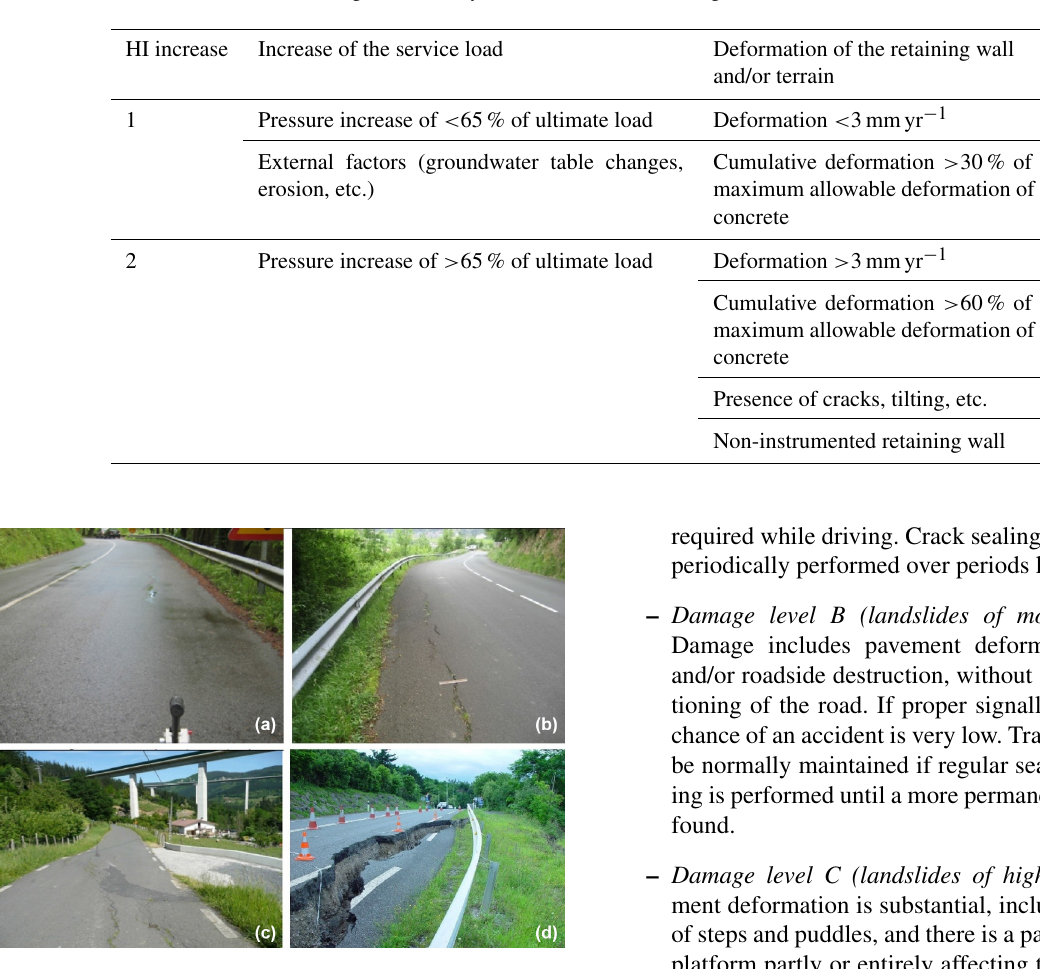
Table 8. Increase factor of the HI according to instability indicators on the retaining walls.